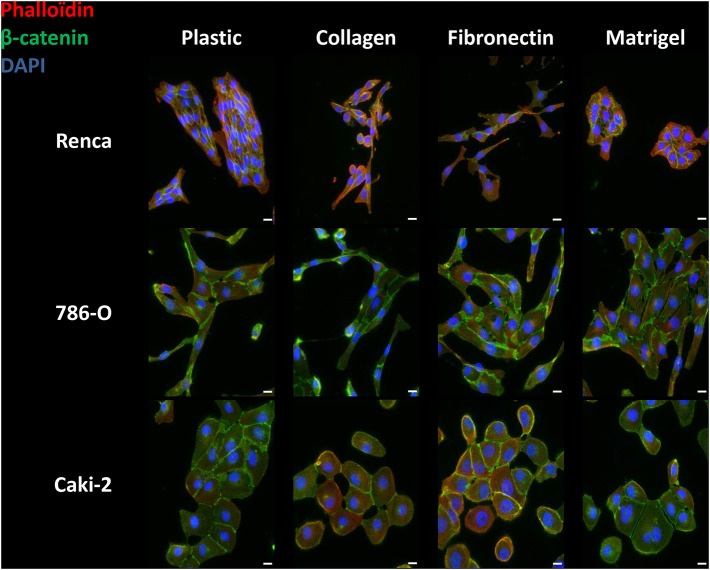
Effect of the different ECM components on the phenotype of RCC cells. Cells were cultured for 24 h on uncoated (Plastic) or Col 1, FN1 or Matrigel glass coverslips, fixed and stained with β-catenin antibody (green), with phalloïdin (filamentous actin, red), and with DAPI (nucleus, blue). Images were captured using a Nikon microscope. Bar: 20 μm. N = 3.